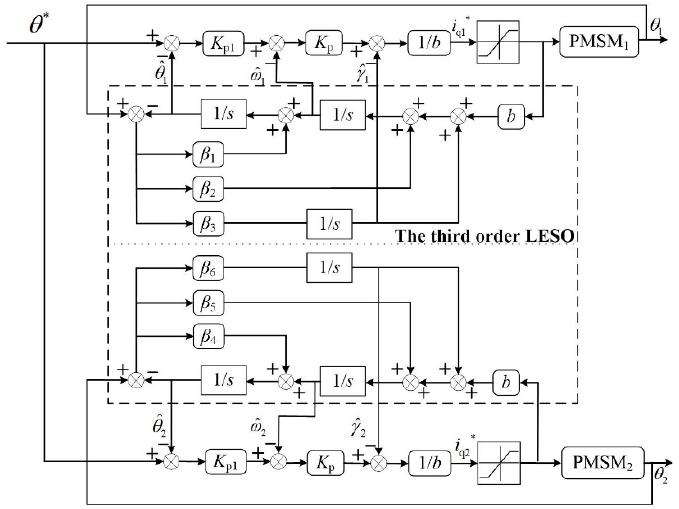
Figure 2. Structure diagram of linear active disturbance rejection controller for dual permanent magnet synchronous motor system.